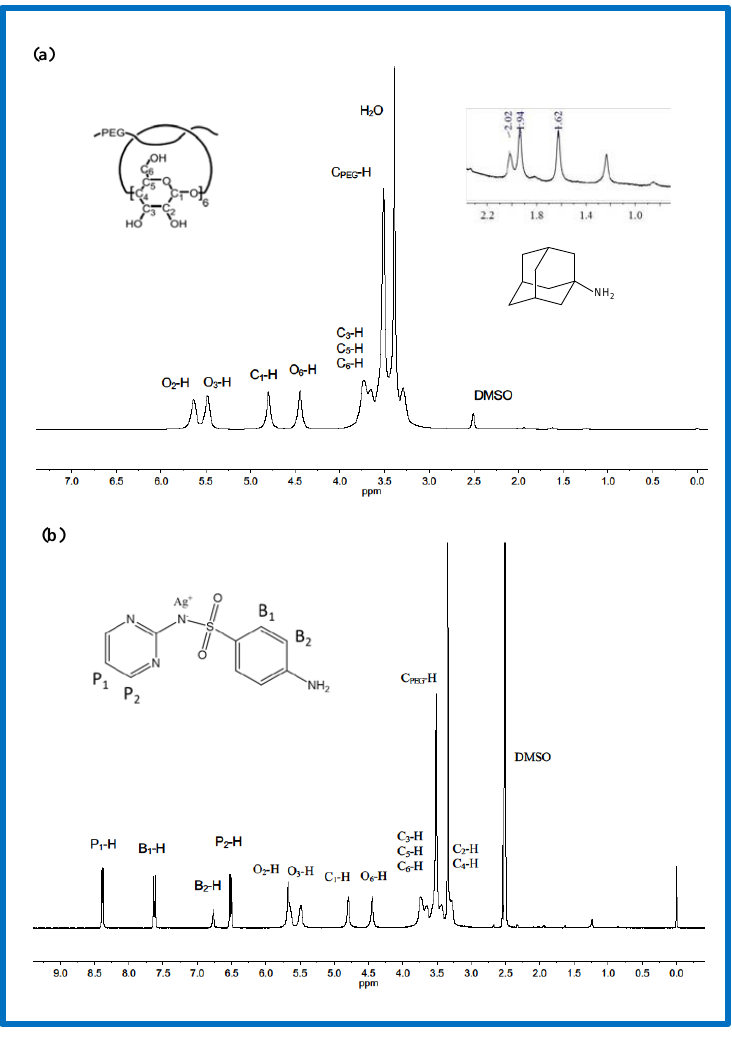
Figure 1. 1 H NMR spectra of ( a ) polyrotaxane (PR) and ( b ) polyrotaxane-silver sulfadiazine complex (PR-(SD-Ag)) in DMSO-d 6 .